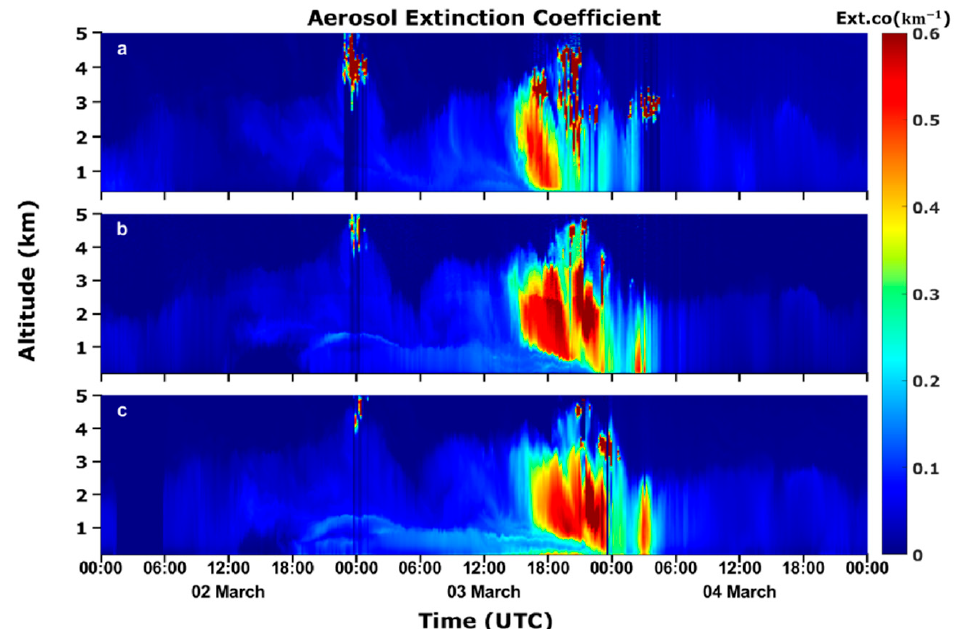
Figure 5. The spatiotemporal distribution of extinction coefficients in each region (( a ) Yanqing, ( b ) Haidian, and ( c ) Nanjiao).